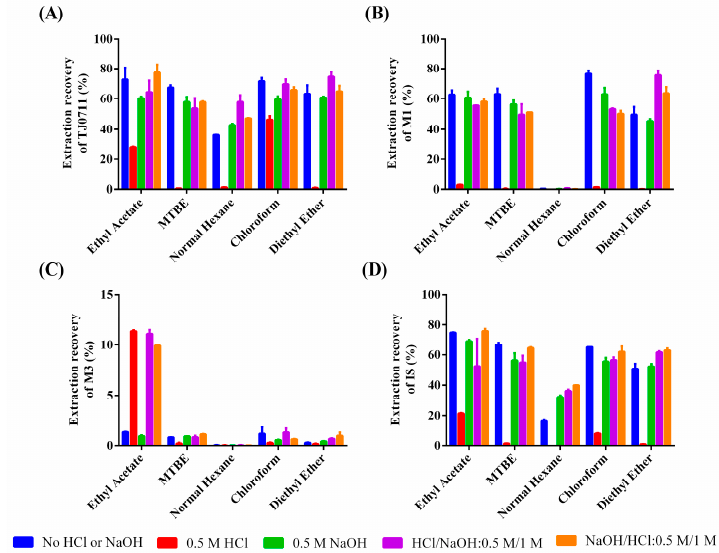
Figure 2. Extraction recovery of TJ0711 ( A ), M1 ( B ), M3 ( C ), and IS ( D ) under various extraction conditions using liquid-liquid extraction. Data are represented as mean ± S.D., n = 3.